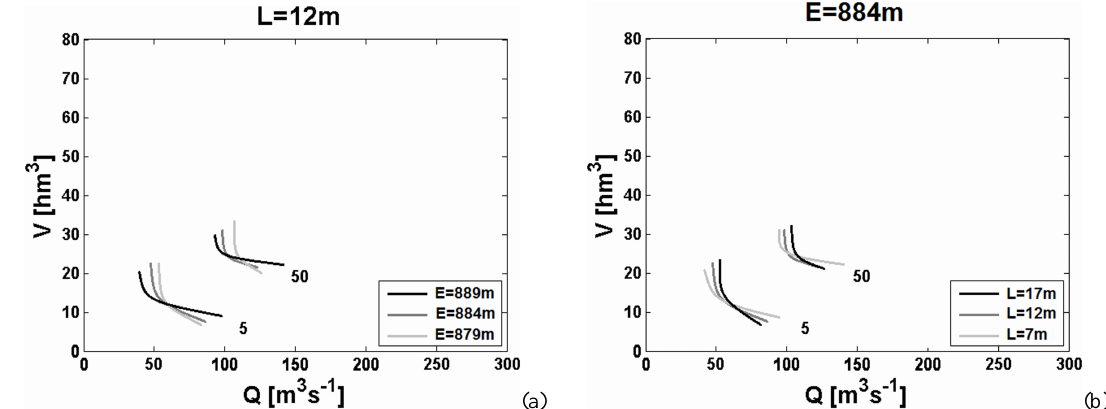
Fig. 12. Detail of the comparison among the routed return period curves when T dam equals 5 and 50yr, varying with: (a) the reservoir volume and (b) the spillway crest